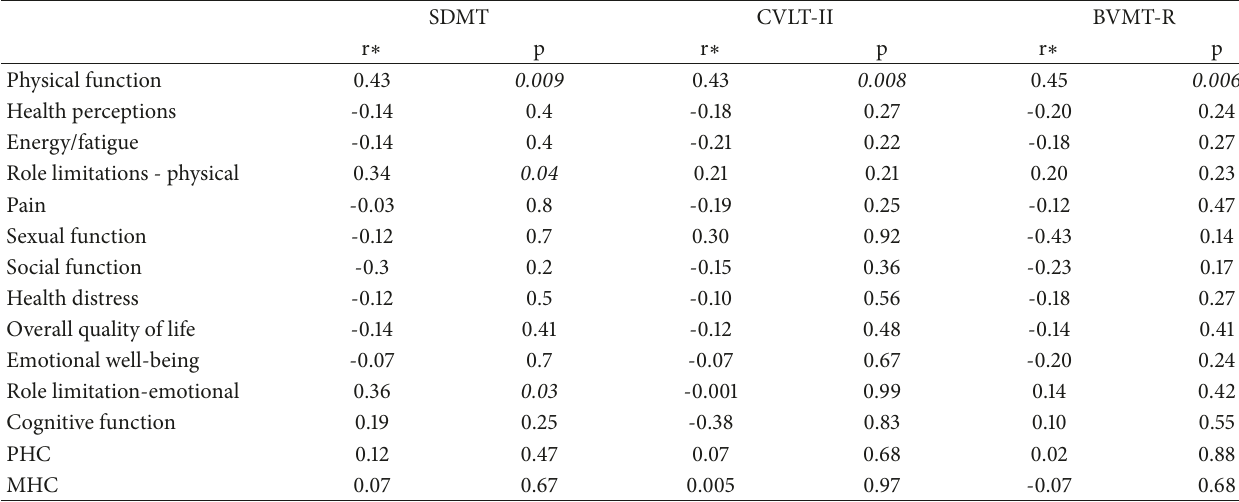
Table 5: Correlation between MSQOL-54 item score and BICAMS